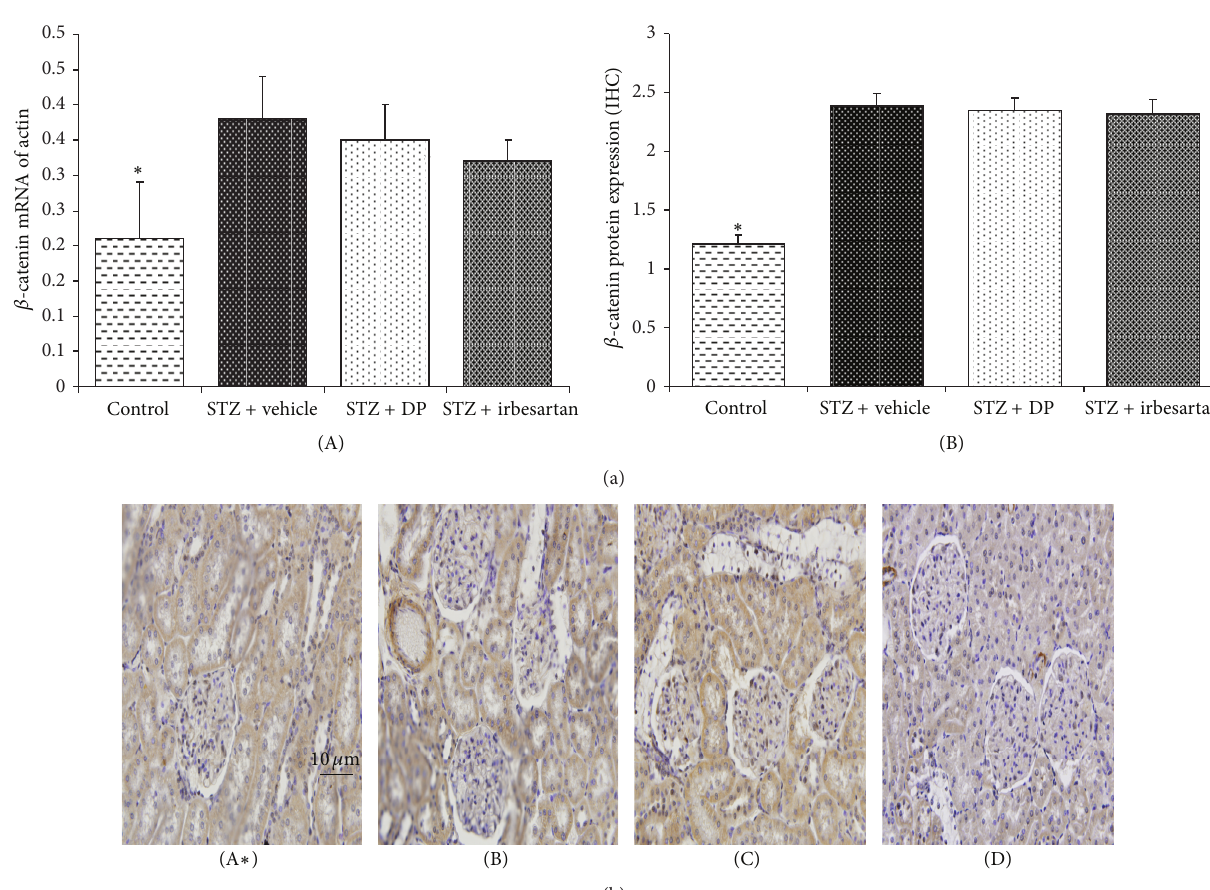
Figure 2: Effect of DP and irbesartan treatments on the renal expressions of 𝛽 -catenin in the rats. (a) Effect of DP and irbesartan treatments on the renal mRNA and protein expressions of 𝛽 -catenin as described in the materials and methods section. (A) The relative levels of the 𝛽 -catenin mRNA were assessed by real-time PCR, and the results were normalized to 𝛽 -actin. (B) The expression of the 𝛽 -catenin protein expressed as a quantitative estimate score. (b) The protein expression specific to 𝛽 -catenin ((A)–(D)) detected by immunohistochemistry (400x magnification): (A) normal glomerulus in the control; (B) STZ + vehicle group; (C) STZ + irbesartan (50mg/(kg ⋅ day)) group; and (D) STZ + DP (500 mg/(kg ⋅ day)) group. All values are the means ± SD ( 𝑛 = 7 ). ∗ 𝑃 < 0.05 , compared with the STZ + vehicle